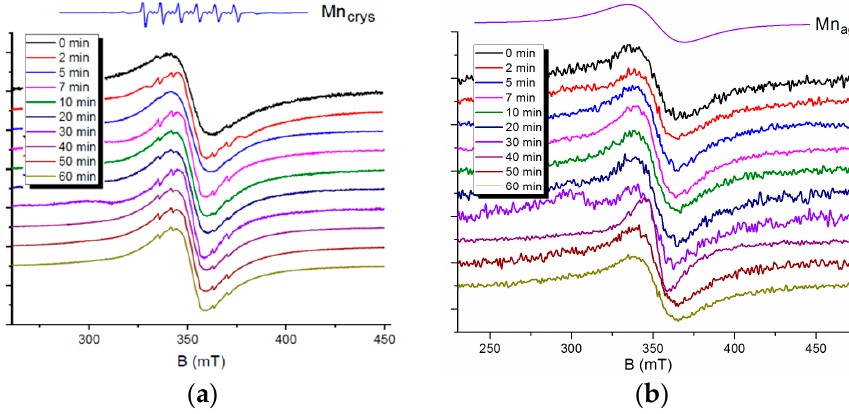
Figure 6. Electron paramagnetic resonance (EPR) spectra of samples taken at various times after the start of synthesis: ( a ) Cd 0.9 Mn 0.1 S; ( b ) Zn 0.9 Mn 0.1 S.